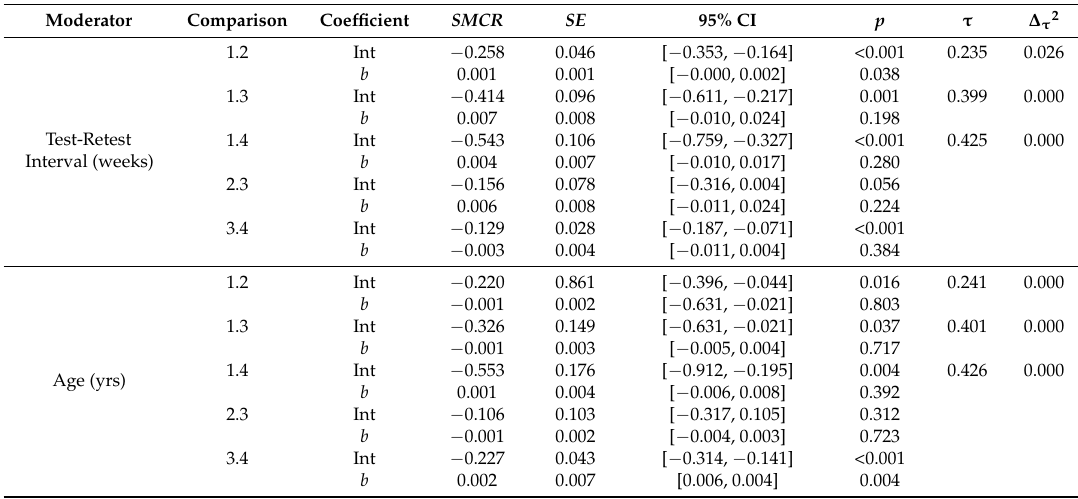
Table 5. Meta-Regressions for Test-Retest Interval and Participant Age.